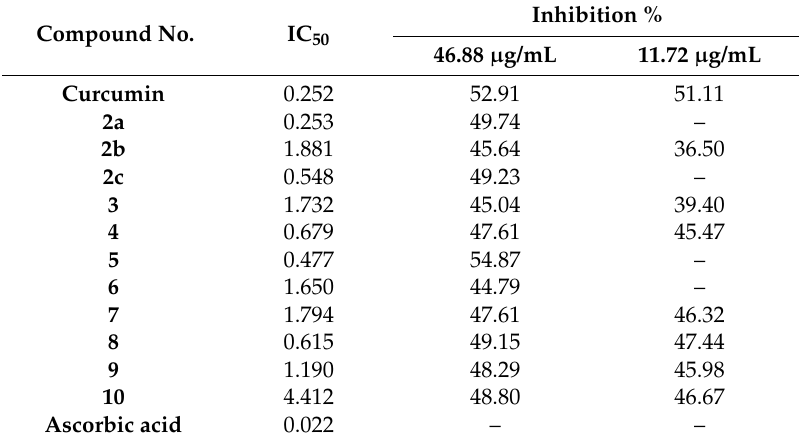
Table 1. IC 50 and inhibition percentage of the tested Curcumin derivatives using a 2,2-diphenyl-1-picrylhydrazyl (DPPH) assay. Compound No.